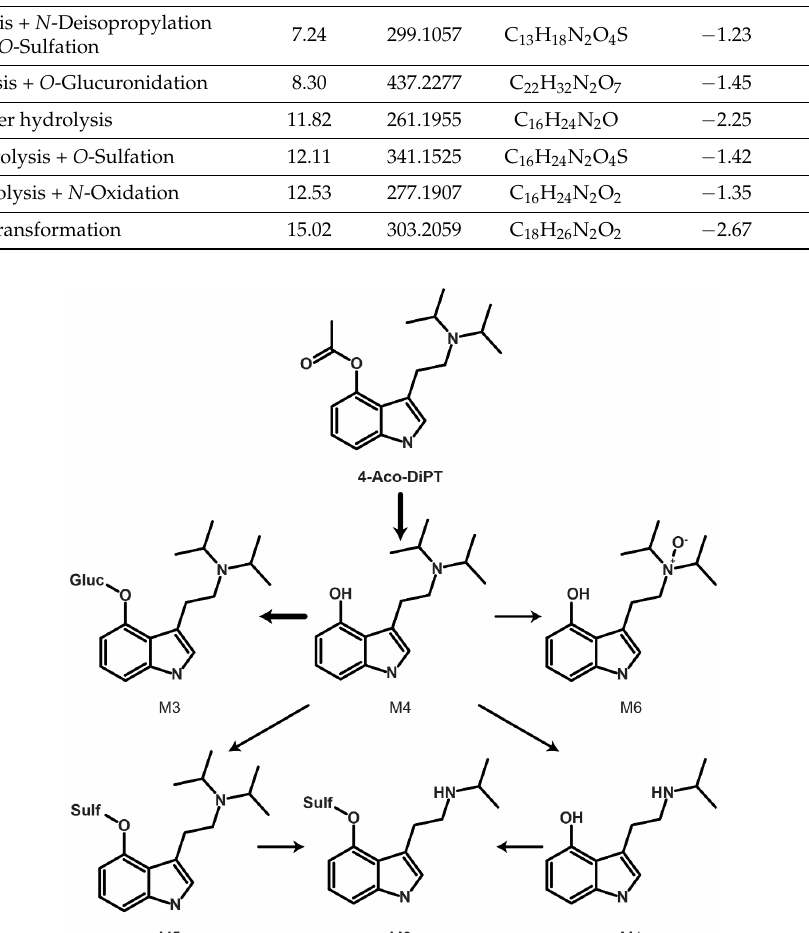
Figure 2. Suggested metabolic fate of 4-AcO-DiPT. Bold indicates major transformations.